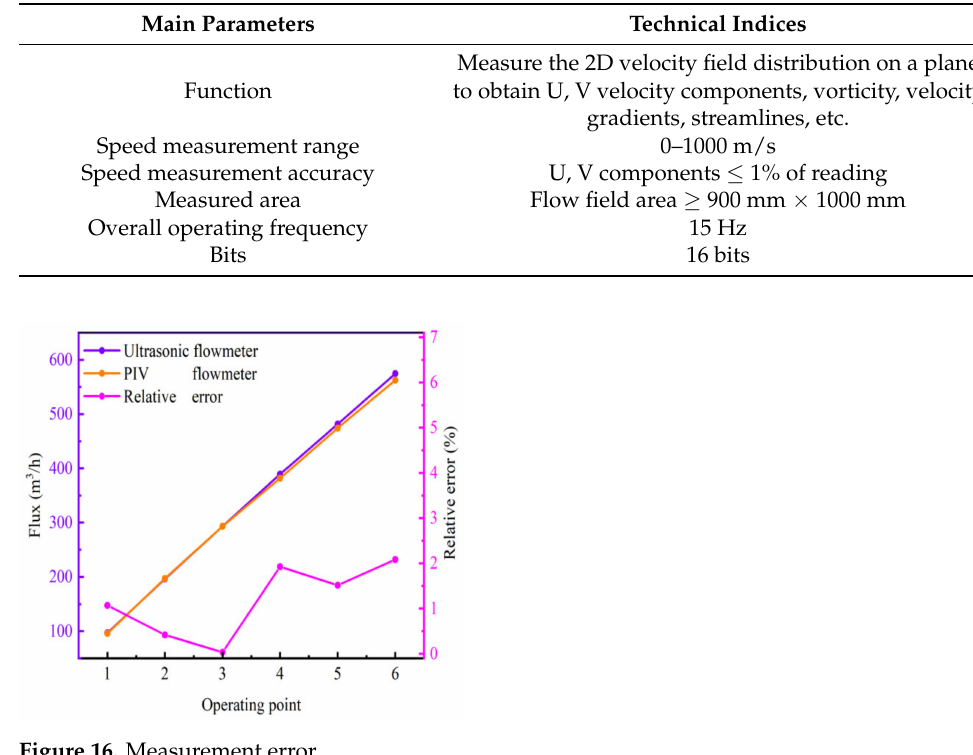
Figure 16. Measurement